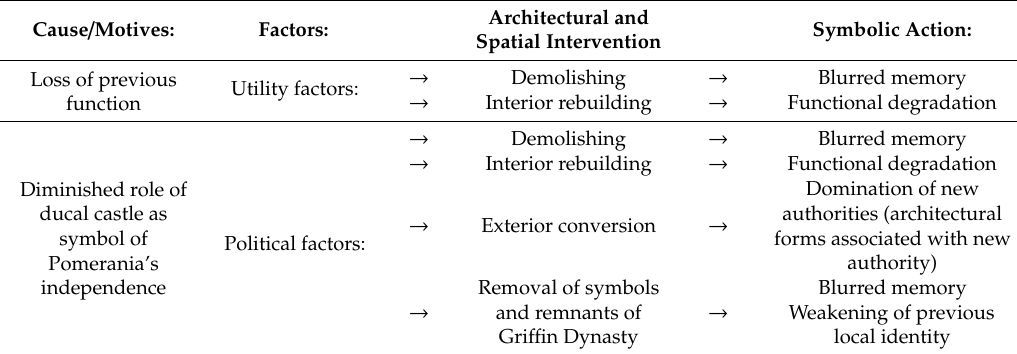
Table 1. Factors that contributed to the transformation of ducal castles in the Prussian-German period.